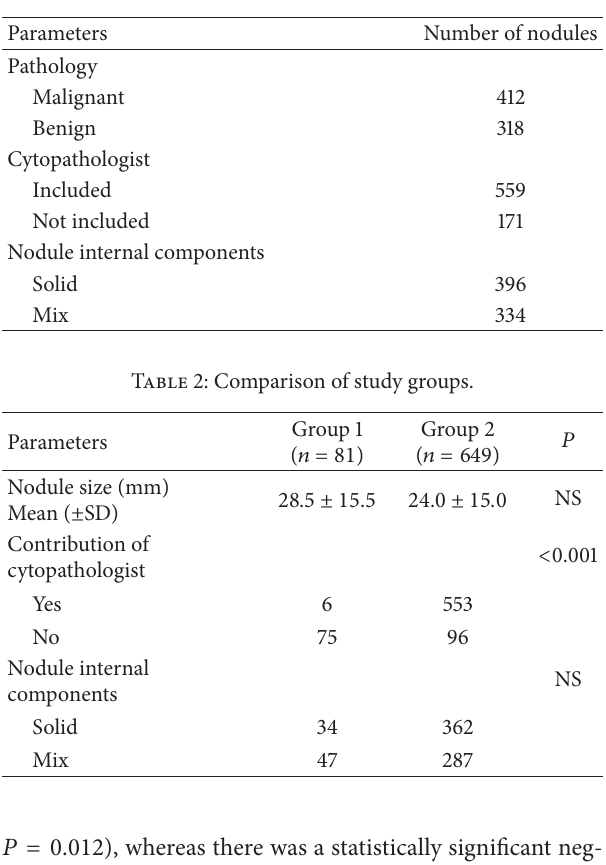
Table 1: General characteristics of the nodules.